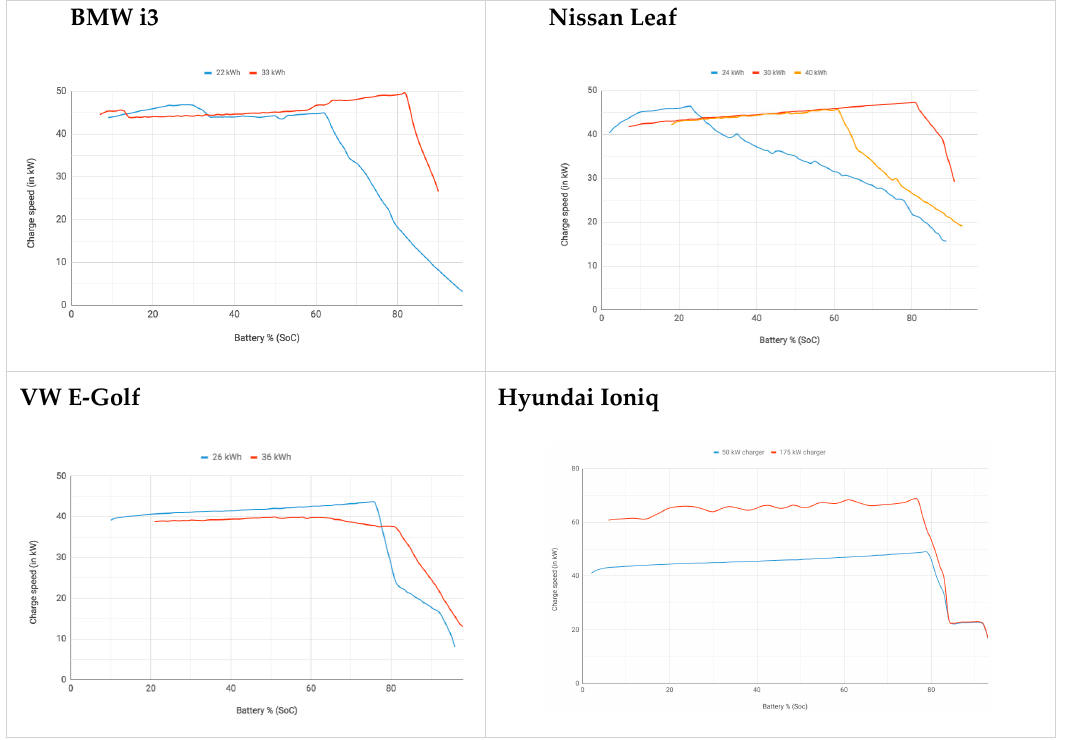
Figure 1. Charge profile of different Battery Electric Vehicles (BEVs). Source: Fastned [26].